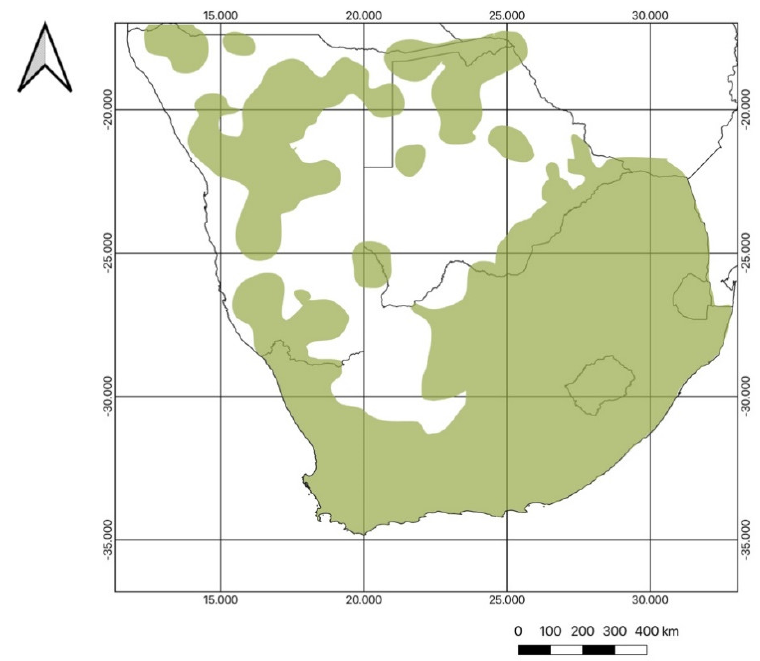
Figure 2. The geographical distribution of the Lamiaceae in southern Africa.